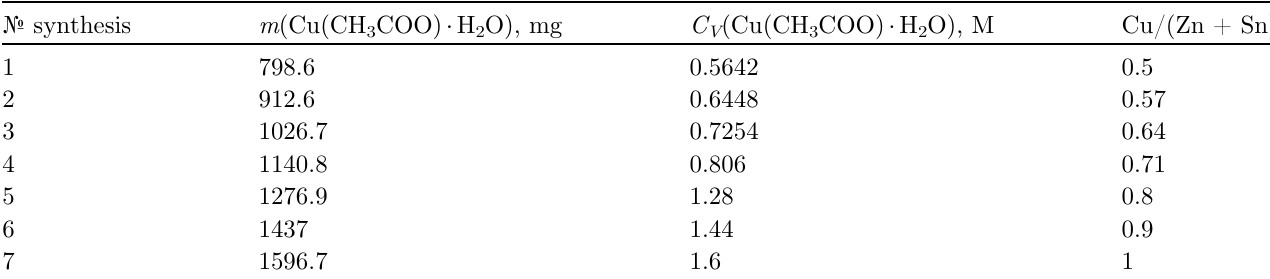
Table 1. The general parameters of synthesis. № synthesis